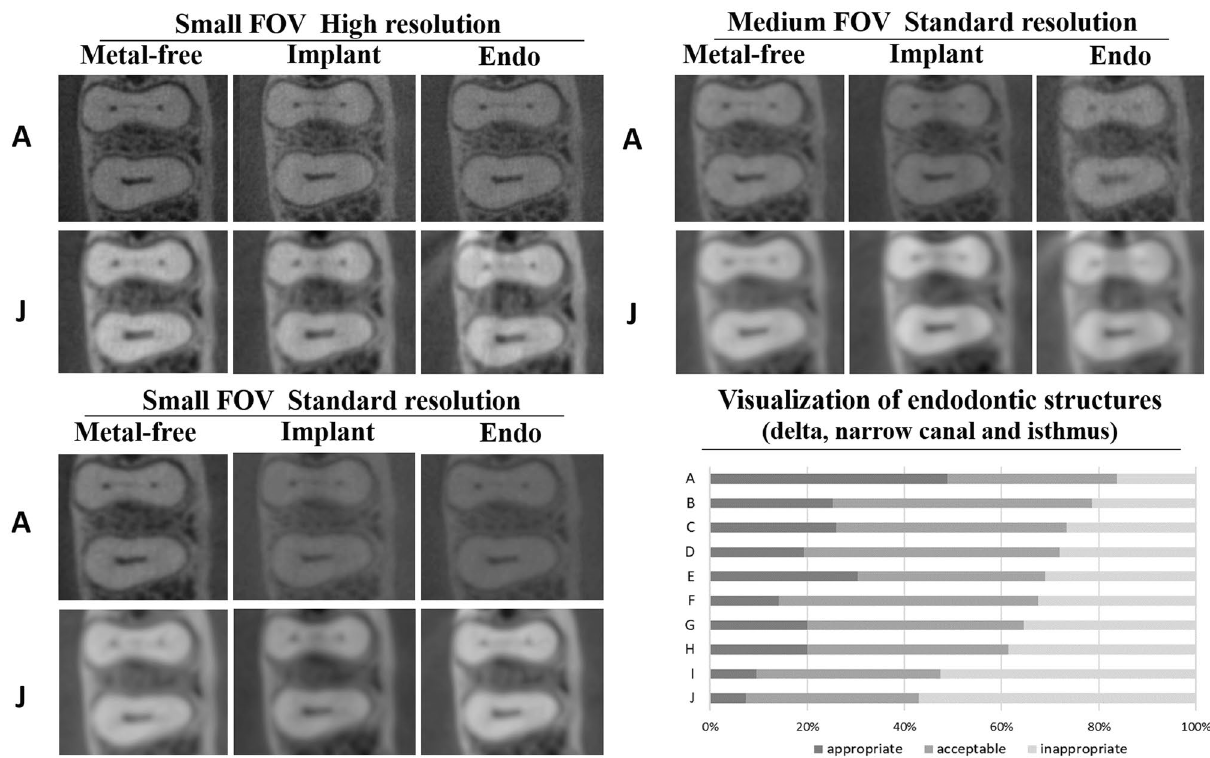
Figure 4. Representative images of isthmus from the devices with the most (A) and least (J) appropriate images for visualization of fine endodontic structures; and stacked bar graph showing the percentage of appropriate, acceptable or inappropriate grades achieved for each CBCT device, taking into account all conditions and the scanning